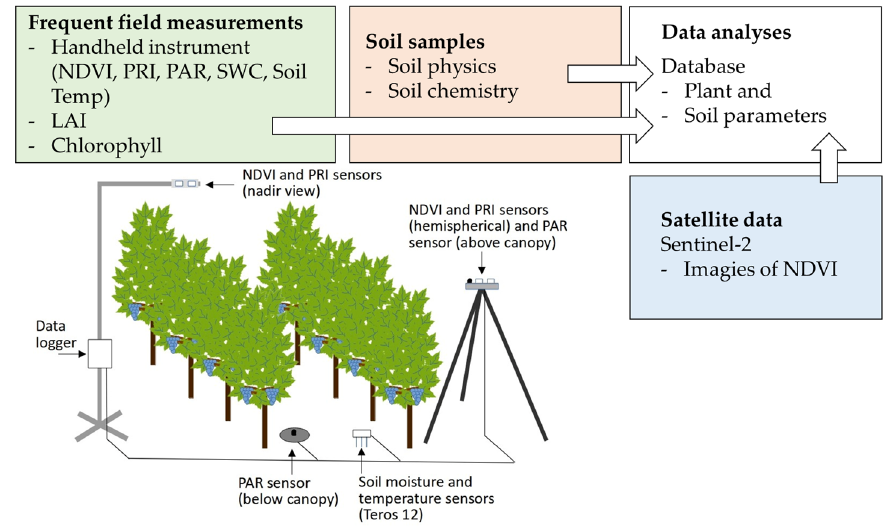
Figure 3. Workflow of the experimental data collection including a schematic diagram of the handheld sensor set setup used to measure selected plant and soil parameters.